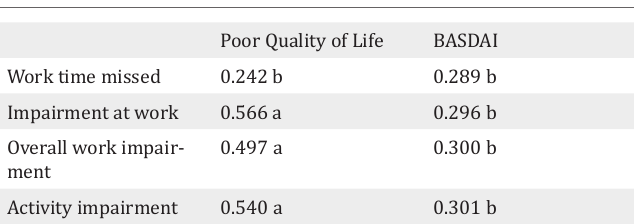
Correlation coefficients between work productivity and activity questionnaire items and Poor Quality of Life, Bath Ankylosing Spondylitis Disease Activity